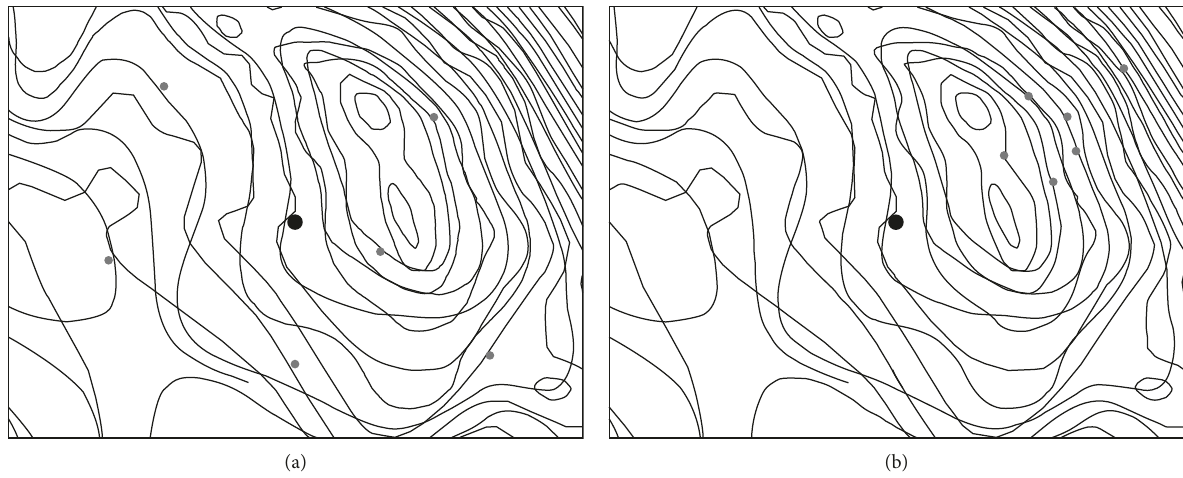
Figure 3: Examples of neighbor selection. (a) Neighbor stations with high spatial dispersion. (b) Neighbor stations with low spatial